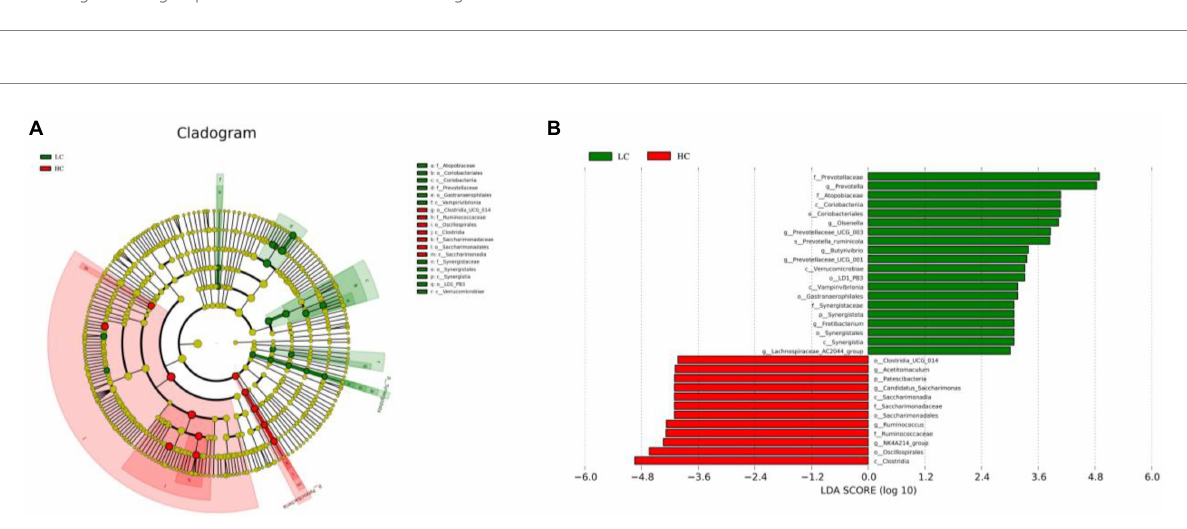
FIGURE 4 LEfSe analysis of rumen microflora of yaks fed low concentrate (LC) and high concentrate diets (HC). (A) Histogram of linear discriminant analysis scores based on categorical information. (B) Linear discriminant analysis effect size classification plot based on categorical